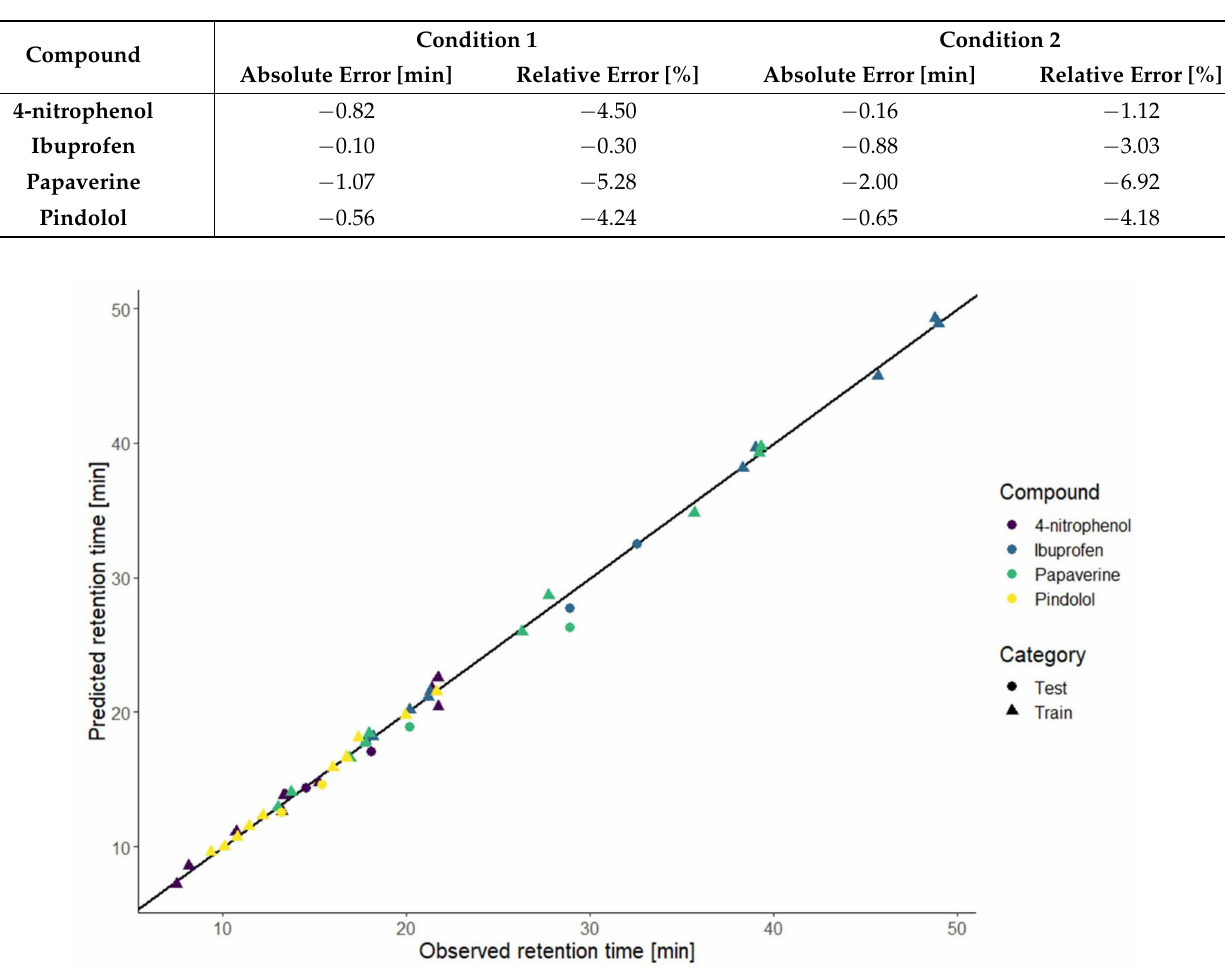
Table 2. Absolute and relative errors of the compound of the first test set in the two new conditions.